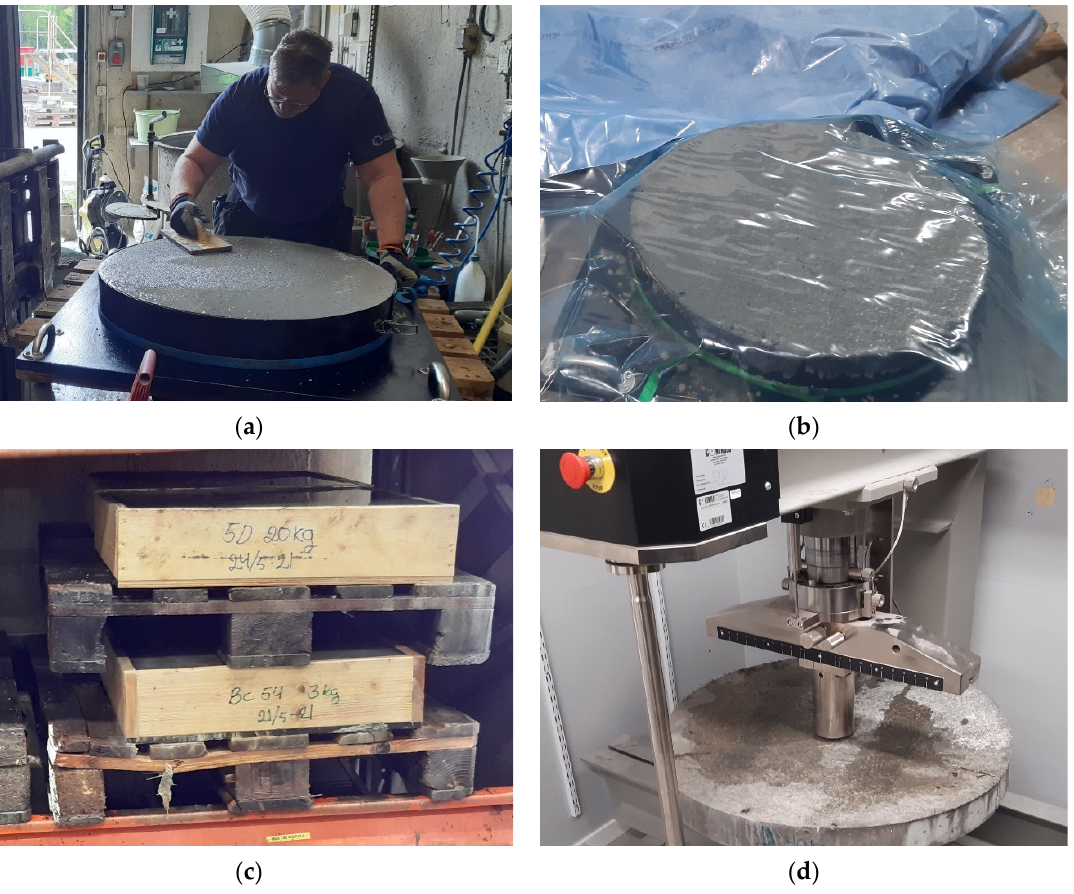
Figure 5. Preparation of panels for testing, casting ( a ), storages of specimen directly after casting ( b ), storage of specimens during hardening ( c ) and set-up for testing of round panel ( d ).